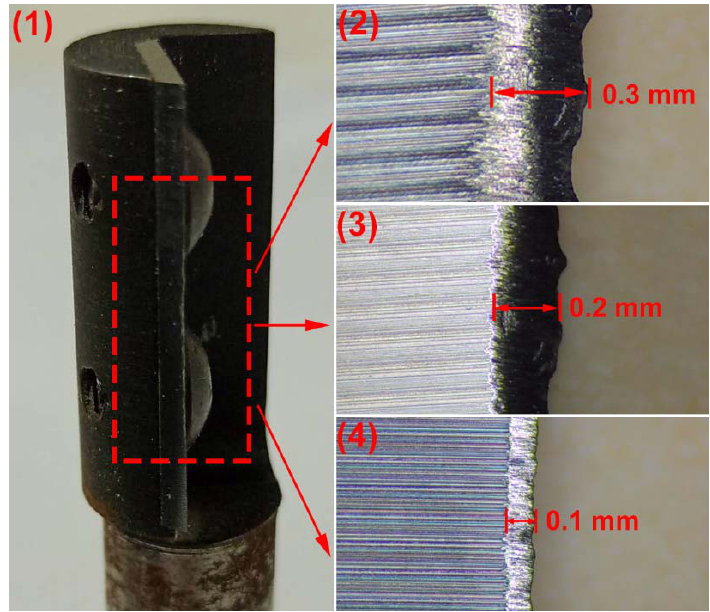
Figure 3. Woodworking tool wear conditions: (1) The tool wear region; (2) The flank wear at 0.1 mm; (3) The flank wear at 0.2 mm; (4) The flank wear at 0.3 mm.